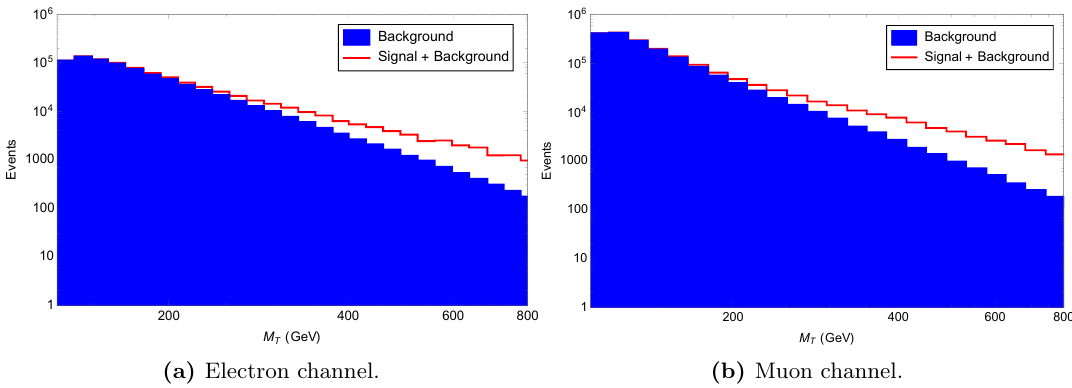
Figure 7. The comparison between the background and the signal+background distributions. For the signal, we take m (cid:31) = 30 GeV and m (cid:30) = 100 GeV with an arbitrary